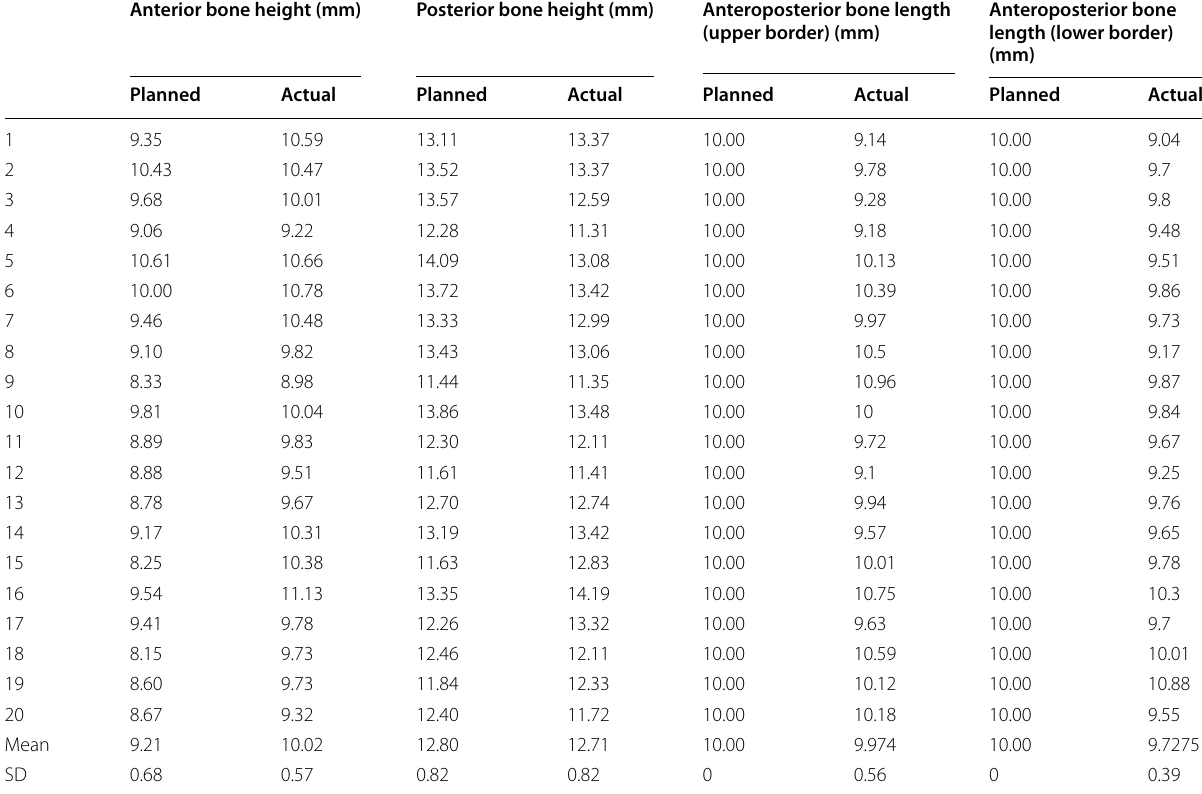
SD standard deviation